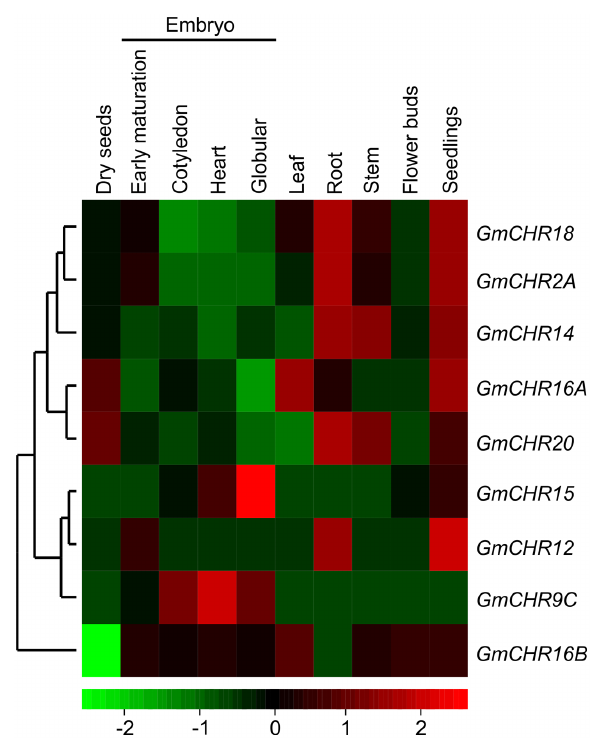
FIGURE 4 | Tissue-specific expression profile of CHR genes in soybean. Soybean RNA-seq data across different tissues were retrieved from the National Center for Biotechnology Information (http://www.ncbi.nlm. nih.gov/geo/query/acc.cgi?acc=GSE29163) for heat map construction. Transcript abundance is indicated by the color scale below the heat map with a gradient from red (high) to green (low).